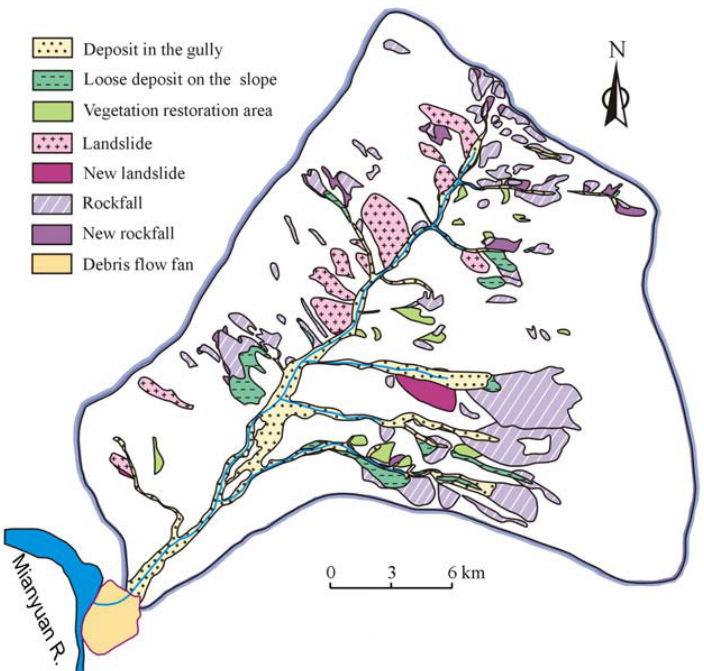
Figure 3. Evolution of the Zoumaling Gully after the Wenchuan earthquake [6].